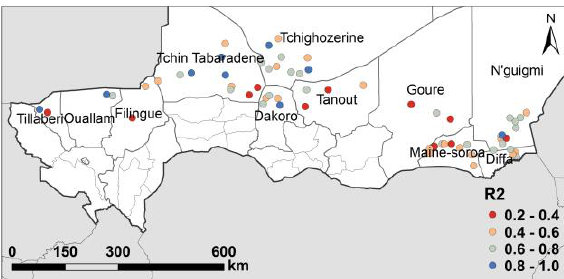
Figure 5. Location of selected sites (names of respective departments indicated) and R 2 of the site specific regression between B m and CFAPAR